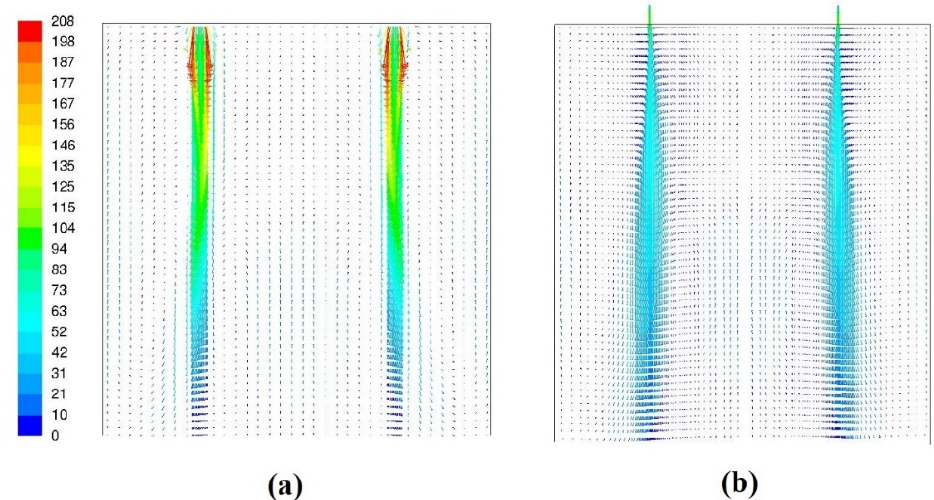
Figure 18. Velocity field in the plane passing through ( a ) the centers of two opposite burners and ( b ) the centers of two opposite powder feeder ports (unit in m/s).